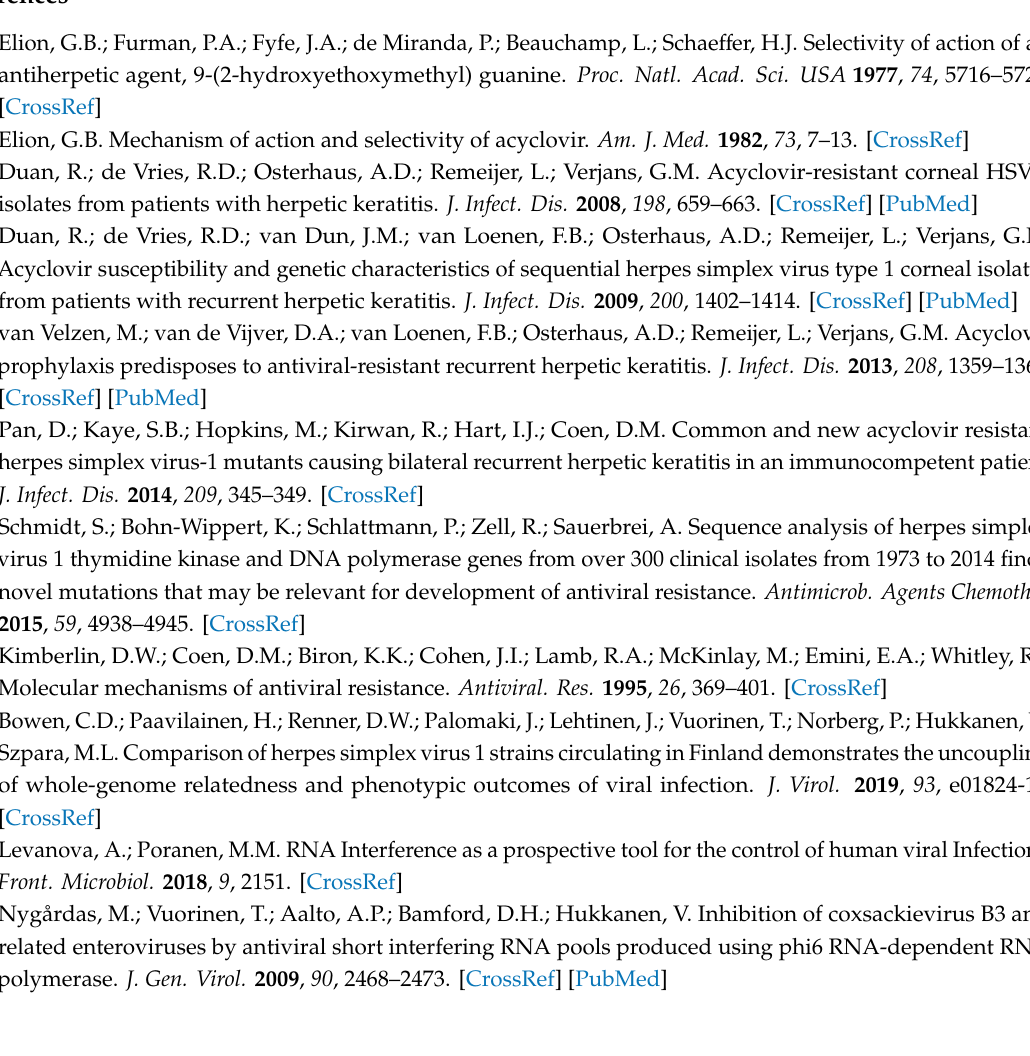
Figure S1: Viability of Vero cells after UL29 siRNA swarm treatment. Figure S2: Comparison of inhibition of viral shedding with specific and nonspecific siRNA swarm treatment in Vero cells using a reference strain (HSV-1 (17 + )) and an ACV-resistant virus (HSV-1 ( ∆ 305)). Figure S3: UL29 siRNA swarm potency or e ffi cacy do not correlate with RNAi target sequence